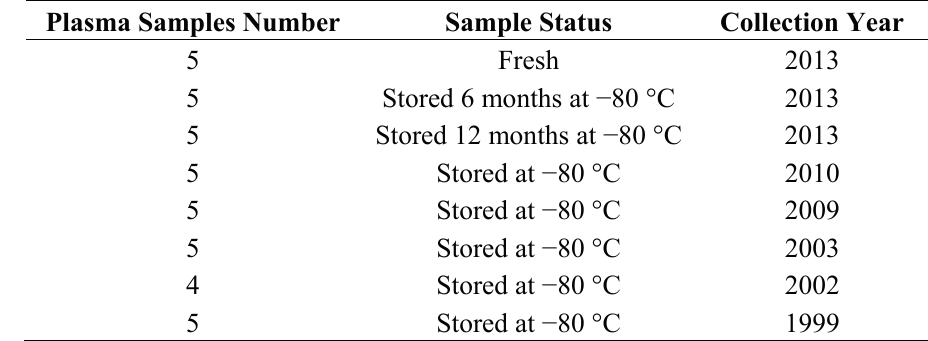
Table 5. Sample Collection: number, collection year, and status of samples analyzed.